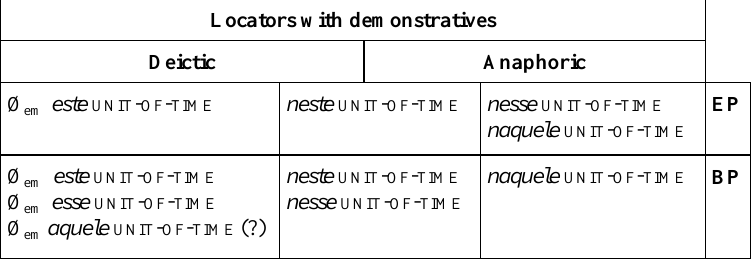
Table IV – Referential properties of locators with demonstratives in EP and BP Locators with demonstratives Deictic Anaphoric neste UNIT - OF - TIME nesse UNIT - OF - TIME neste UNIT - OF - TIME nesse UNIT - OF -